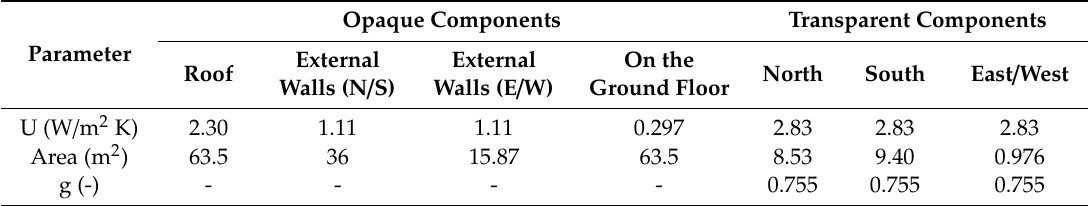
Table 1. Classroom envelope characteristics [27].